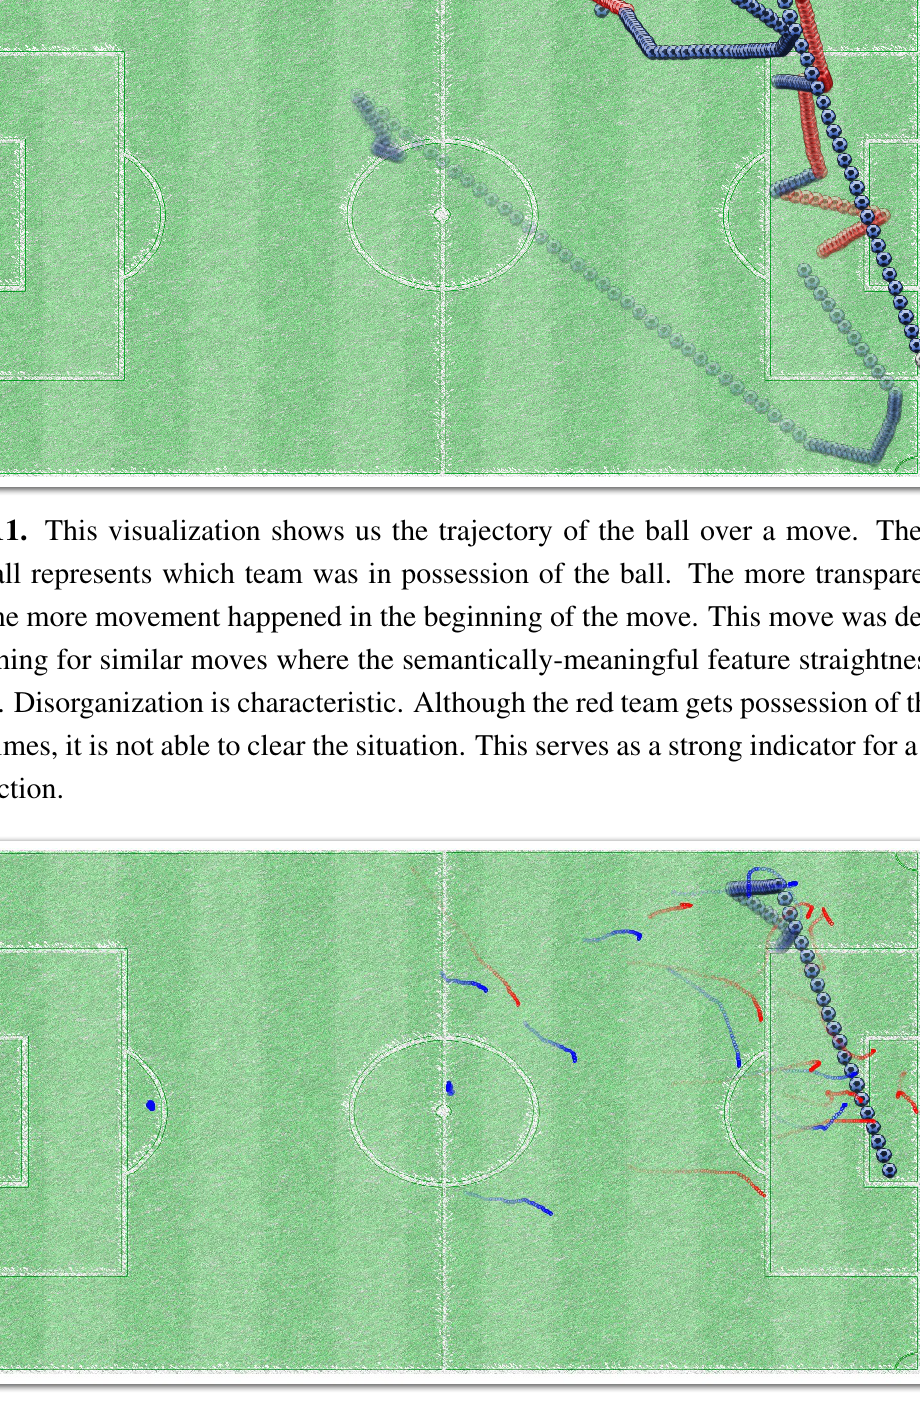
Figure 12. Same move as in Figure 11. Depicted is the cross that led to the annotation as a possible suggestion for the analysis. Furthermore, we can see the movement of the players of both teams. The color of a player represents his or her